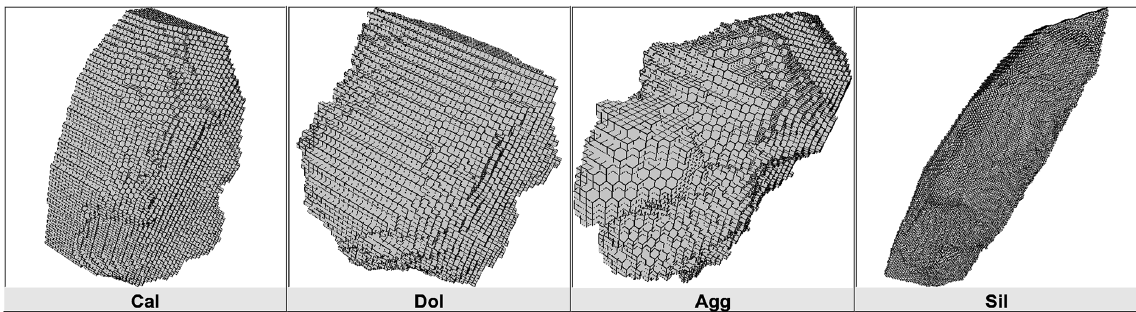
Figure 1. Renders of the DDA representations of the four target particles. The particles are depicted here with one-eighth of the dipole resolution compared to the calculations.